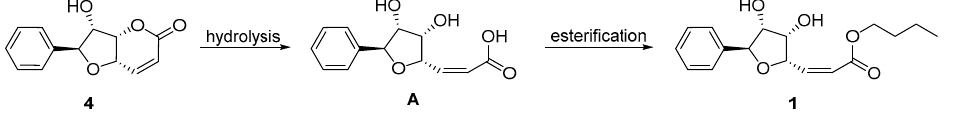
Additionally, compound 4 is the major component of G. Pentaphylla (0.006%), suggesting compound 1 might be derived from 4 (Figure 3). After hydrolysis, 4 might become intermediate A , and A was esterificated to form 1 . Through comparison between compounds 1 and 4 , the absolute configuration of 1 was established and assigned the trivial name glyfuran.